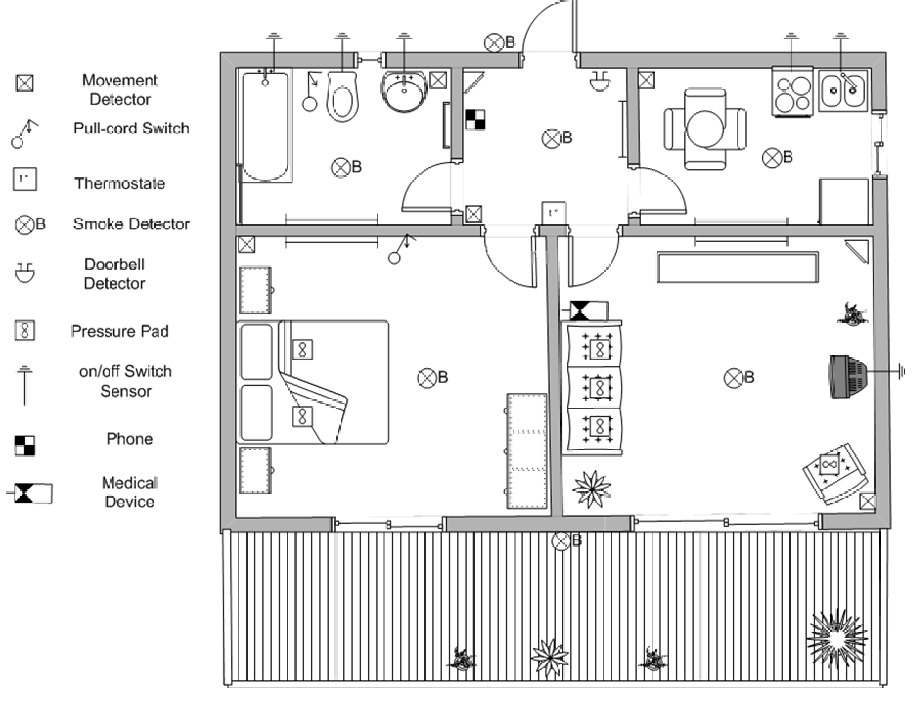
Fig. 1. The layout of an example Smart